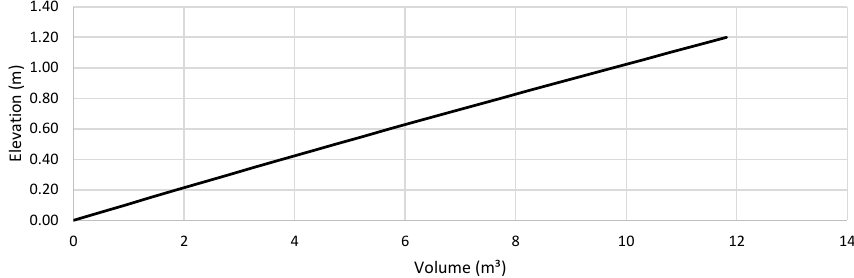
Figure 5. Reservoir curve for model tests.